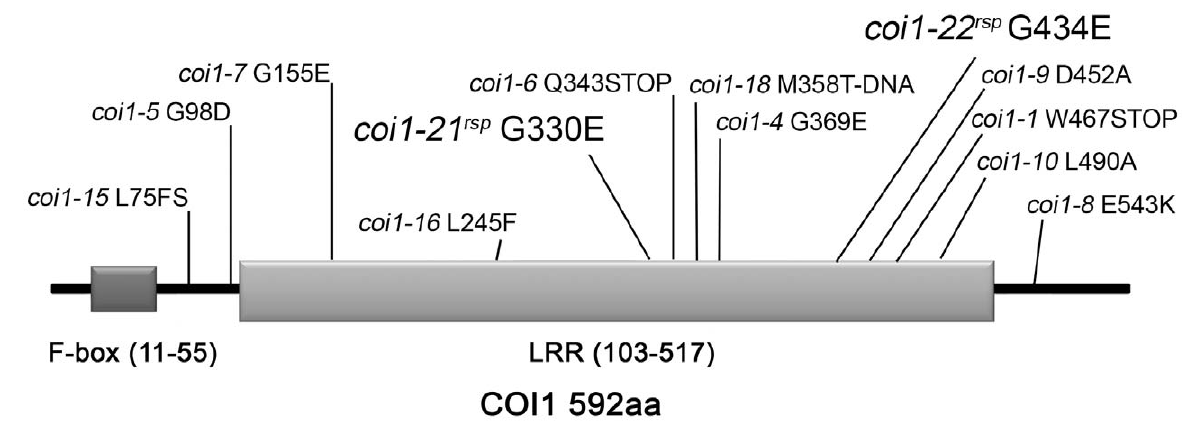
Figure 1. Mutations identified in COI1. The F-box domain and the LRR domain are shown in dark and light gray, respectively. The allele designation and associated amino acid change is shown in relation to its linear position. New alleles introduced in this paper are shown with larger font.